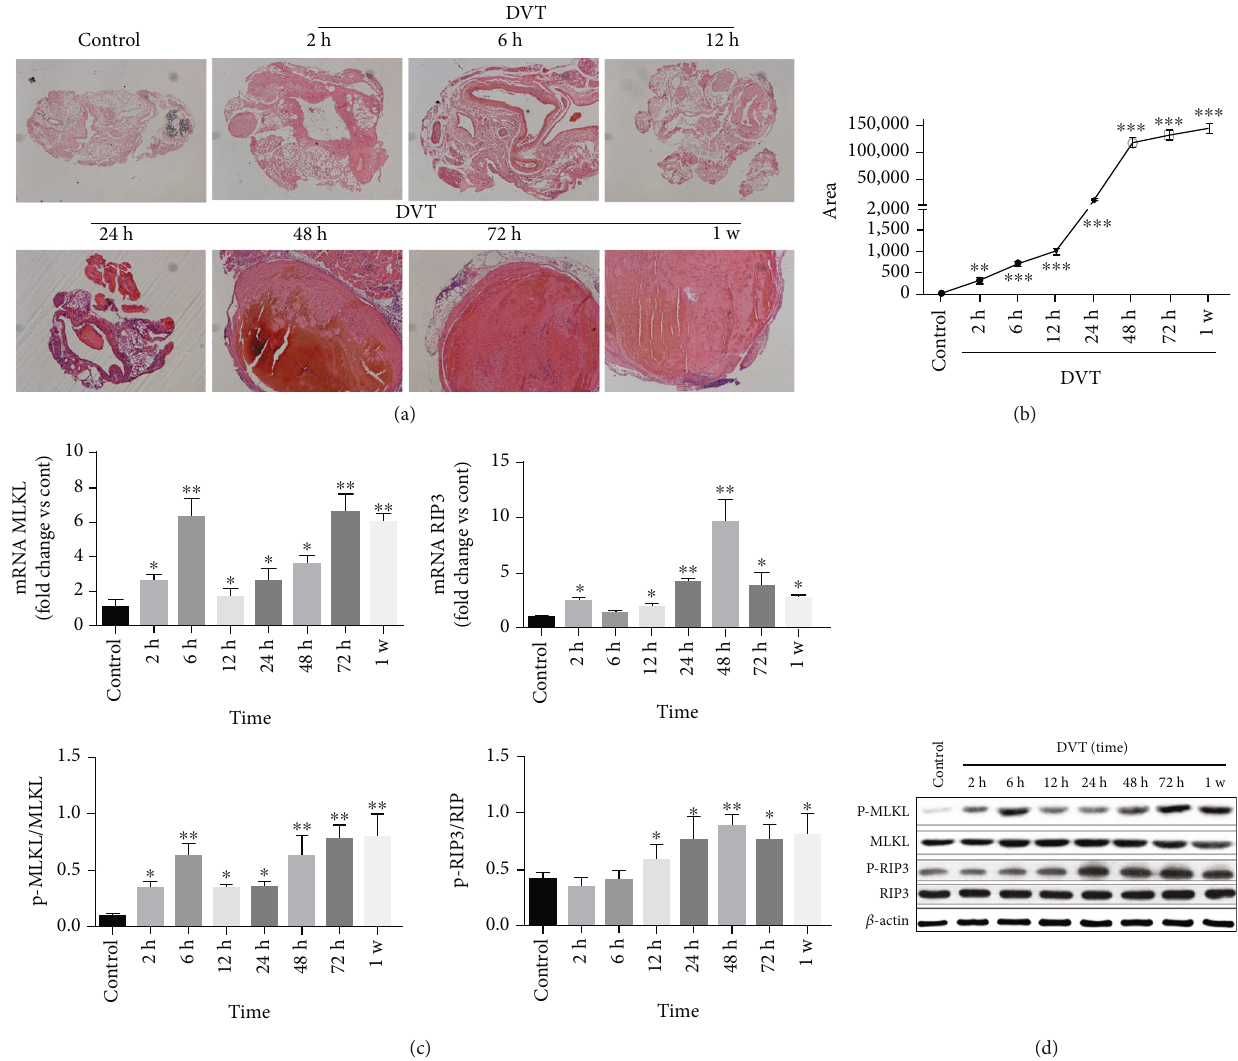
Figure 1: RIP3 and MLKL phosphorylation increased with time after IVC thrombosis. RIP3 and MLKL phosphorylation increased with time after IVC thrombosis. (a) H&E staining to observe thrombosis ( n = 6 , scale = 50 μ m, 100x). (b) Cross-sectional thrombus area measured on H&E images by Image-Pro Plus 6.0. (c) The expression level of MLKL mRNA and RIP3 mRNA in normal IVC wall and IVC wall of di ff erent time points after IVC ligation were determined by qRT-PCR. GAPDH was used as an internal reference. (d) Western blot for the detection of RIP3, p-RIP3, MLKL, and p-MLKL proteins in the IVC wall, using β -actin as the internal reference. The ImageJ image software analysis was used to test and analyze the expression ratios. The bar chart shows the ratio of protein gray value to total protein gray value. Six mice were tested at each time point. ANOVA was used for statistical analysis. ∗ P < 0 : 05 , ∗∗ P < 0 : 01 , and ∗∗∗ P < 0 : 001